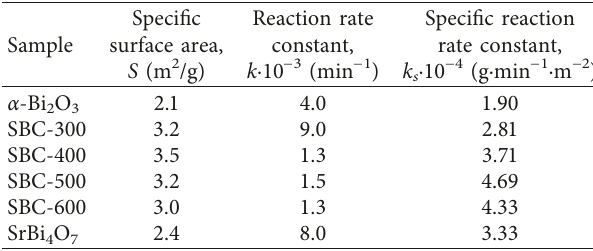
Table 2: The catalytic activity of the resulting compositions and single-phase